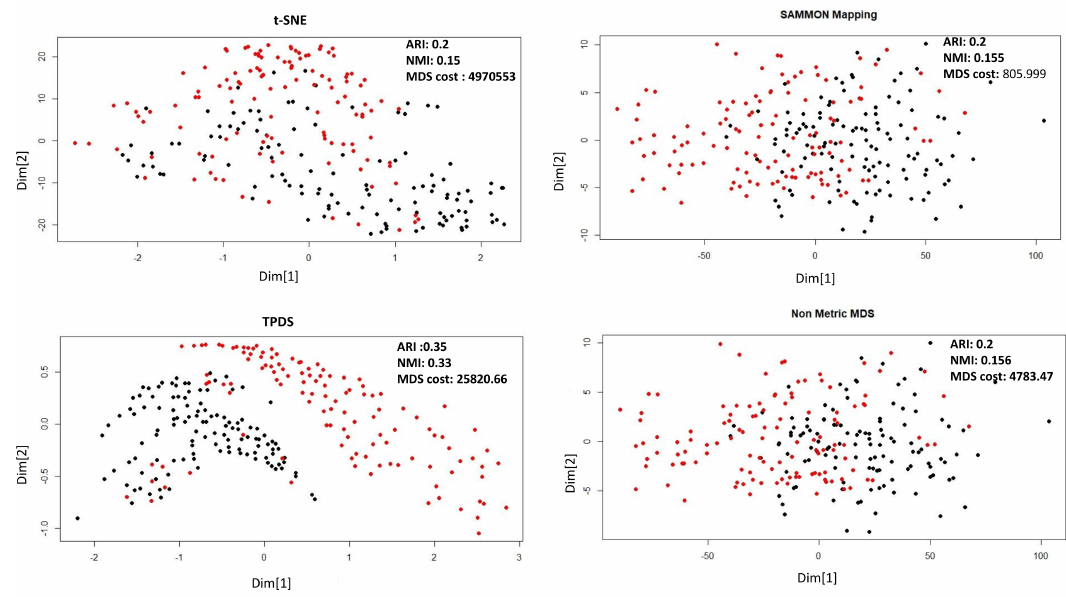
Figure 1. Dimension reduction of Parkinson’s data set by Naranjo et al. [14] using four di ff erent methods. The distance stress-based cost is represented here as